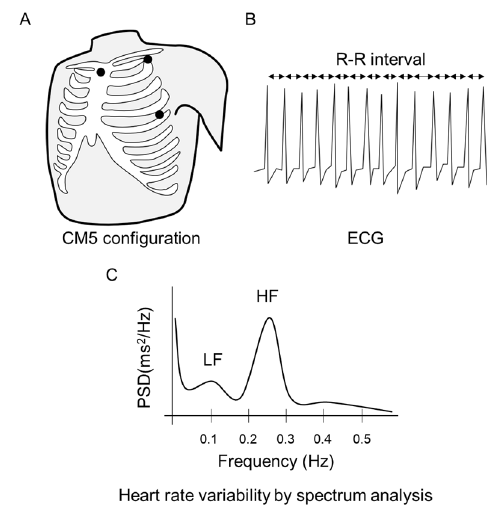
Figure 2. Overview of the electrocardiogram and heart rate variability. ECG, electrocardiography; LF, low frequency; HF, high frequency.